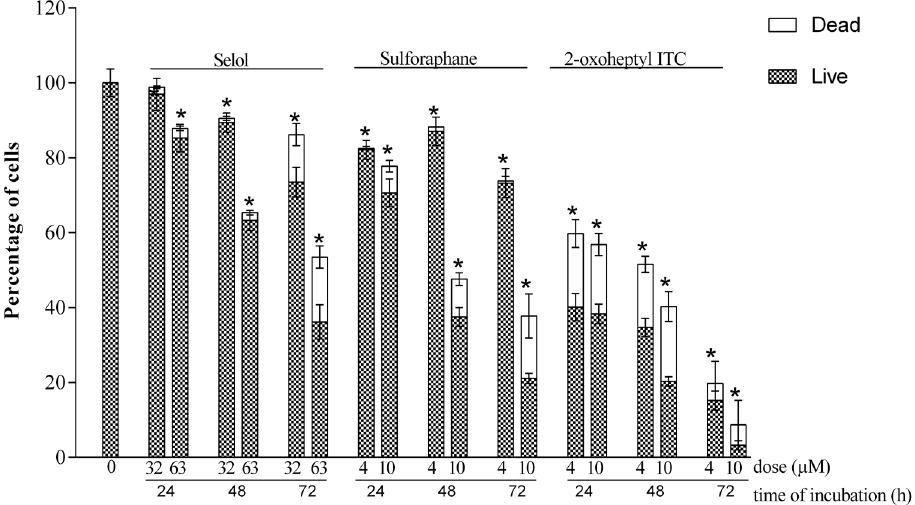
Fig 3. Effects of Selol, SFN and 2-oxoheptyl ITC on total cell numbers and the live/dead cell ratios. Cells were incubated with compounds for 24, 48 and 72 h and stained with FDA/PI. Data analysis was performed using Fluoview500 software (version 5.0) and ImageJ program. * significant difference, p < 0.05.